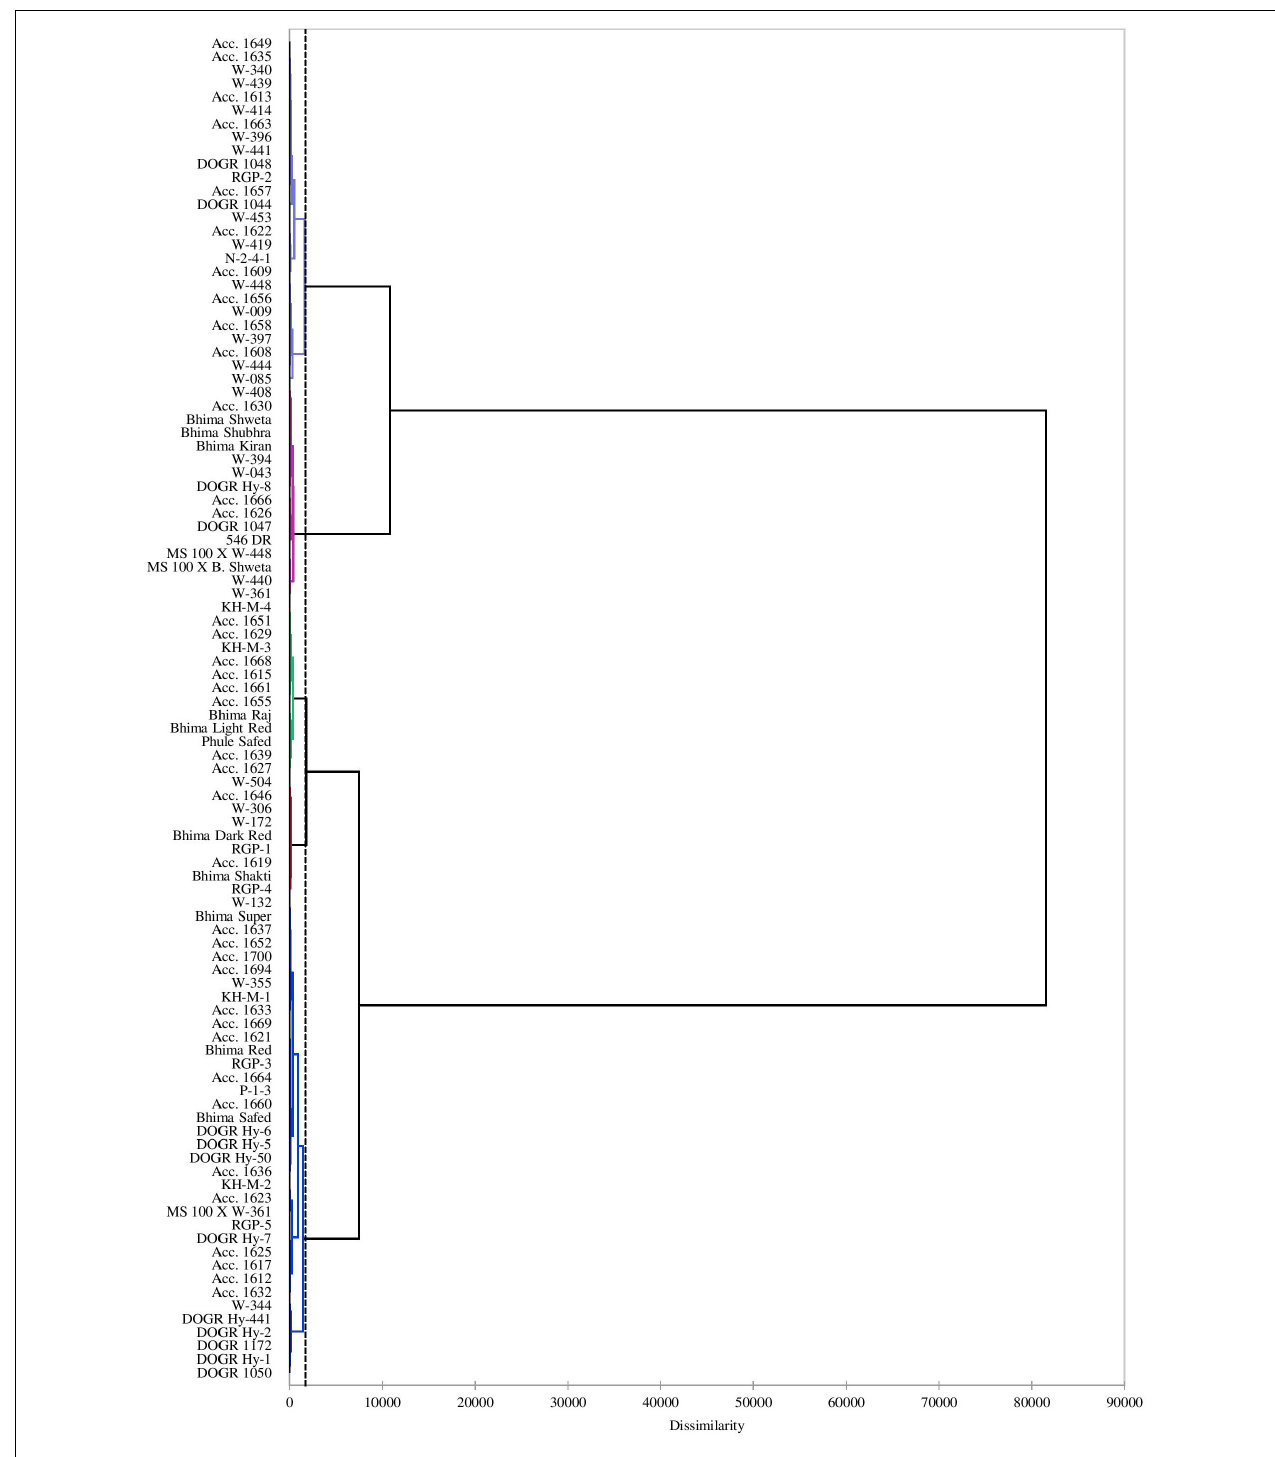
FIGURE 1 | Dendrogram using Ward’s method presenting distribution of 100 onion genotypes under drought stress.